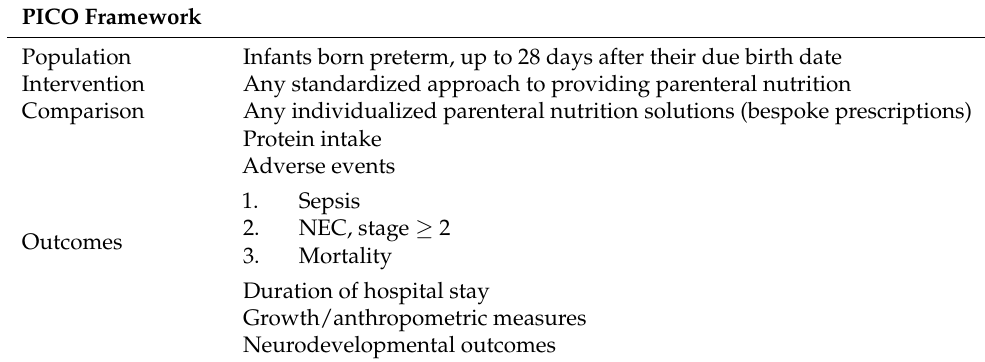
Table 1. Research questions defined following the PICO framework